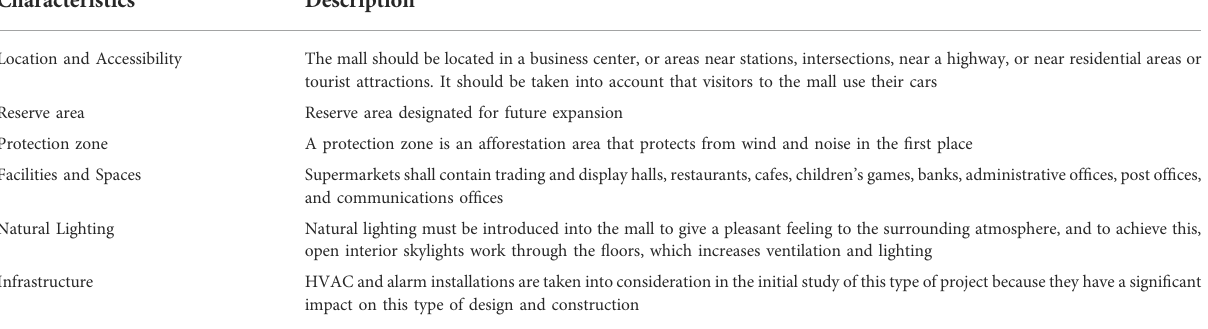
TABLE 2 Characteristics and description of the shopping malls for